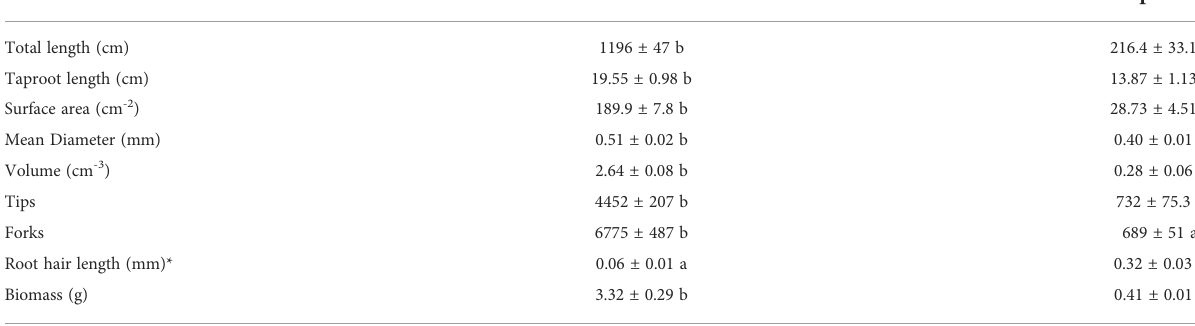
*Values obtained by stereomicroscope image analysis. Values represent the mean ( ± SD). Different letters indicate signi fi cant statistical differences between European beech and Norway spruce obtained by Student ’ s t-test, p < 0.05. N =